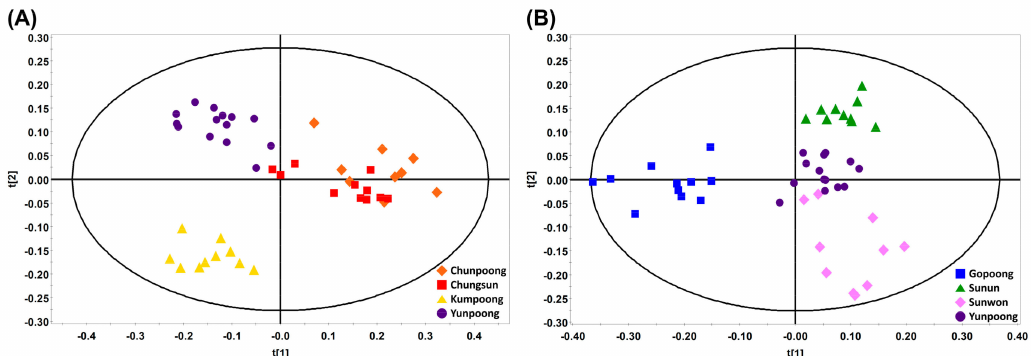
Figure 5. Multivariate statistical analyses of NMR spectra from di ff erent cultivars. ( A ) Comparison of (cid:4) representative cultivars in each variant ( , Chunpoong; (cid:4) , Chungsun; (cid:78) , Kumpoong; • , Yunpoong). (cid:4) ( B ) Comparison of cultivars in violet-stem variant ( (cid:4) , Gopoong; (cid:78) , Sunun; , Sunwon; • , Yunpoong).